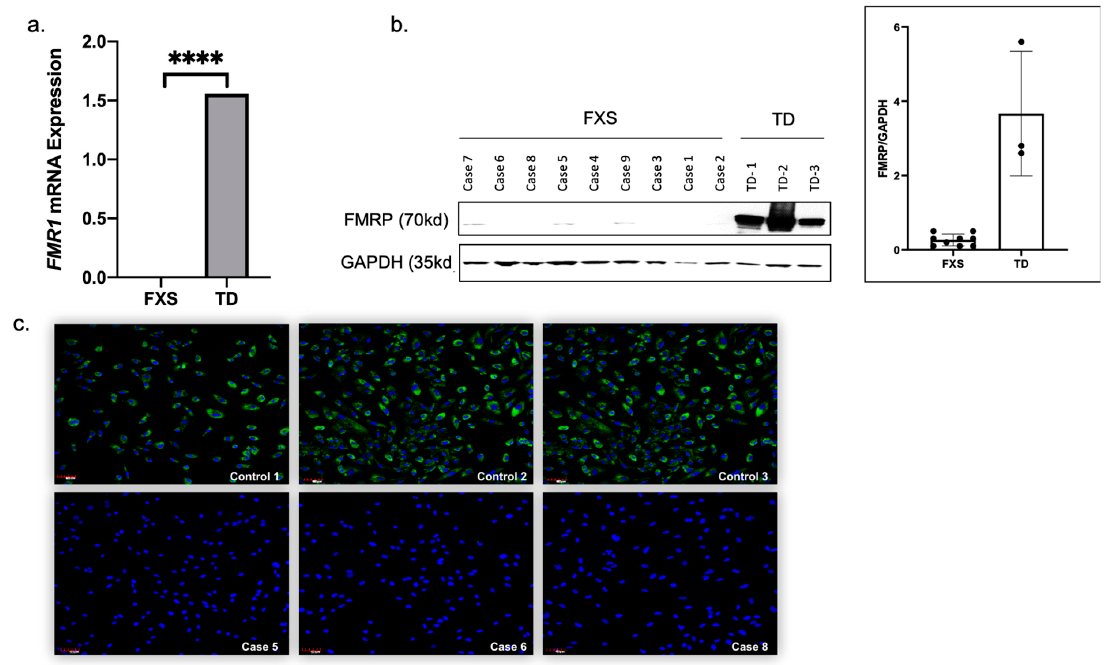
Figure 5. Urine-derived epithelial cells expressed FMR1 mRNA and FMRP protein. ( a ) Bar plot showing the significantly higher expression ( p < 0.0001) of FMR1 mRNA in TD (n = 1) as compared to FXS patients (n = 5). ( b ) Western blot protein expression patterns showing complete loss or significantly lower ( <= 0.1%) FMRP expression (n = 9, p < 0.0001) in FXS patient derived epithelial cells compared to TD (n = 3). Data also show the ratio of FMRP protein / GAPDH. ( c ) Confocal images and in-situ immunofluorescence showing high expression of FMRP protein (green) localized to the cytoplasm of the epithelial cells derived from normal individuals (Top panel; n = 3), while complete loss or low FMRP expression has been observed in the cells derived from FXS patients (Bottom panel; n = 3).